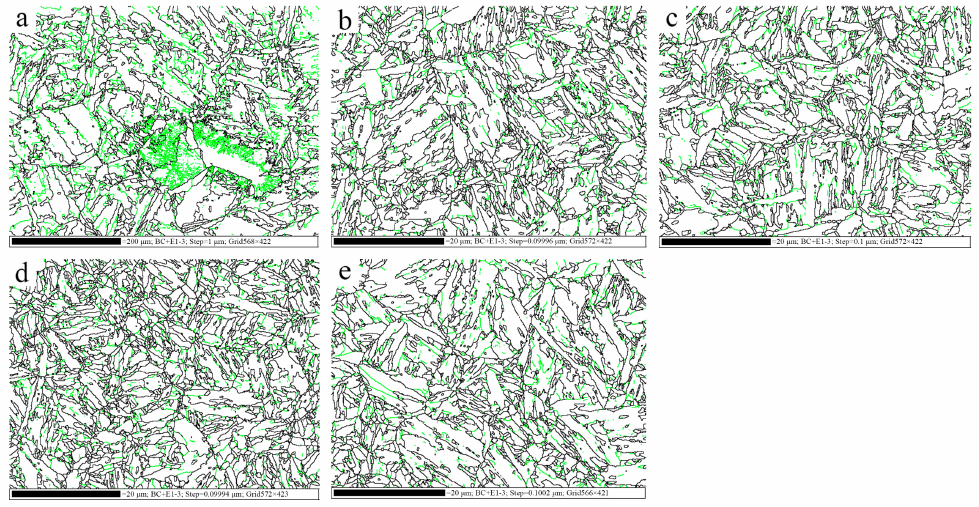
Figure 14. The grain boundary maps for ( a ) BM, ( b ) HDL, ( c ) HDT, ( d ) CFL, and ( e ) CFT.